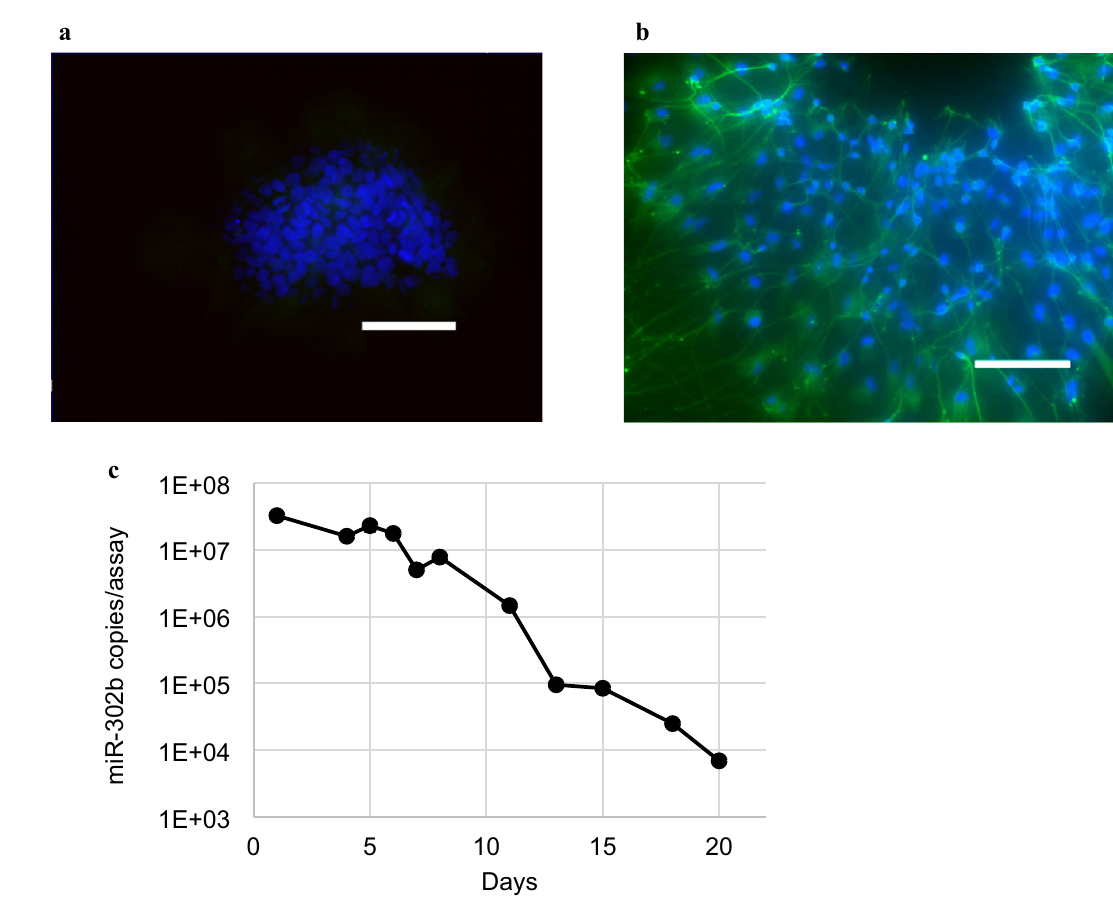
Figure 5. miR-302b expression level in the culture supernatant decreased as iPSCs were induced to differentiate to NPCs. The images of cells ( a ) before inducing differentiation, that is, iPSCs, and ( b ) on day 15 of the iPSC- derived NPC-induction process. Blue channel represents the nuclei and green is TUJ1. Scale bar is 50 μm. ( c ) The level of miR-302b in the culture supernatant continually decreased during the induction of iPSCs to NPC differentiation. Error bar = ± 3SD